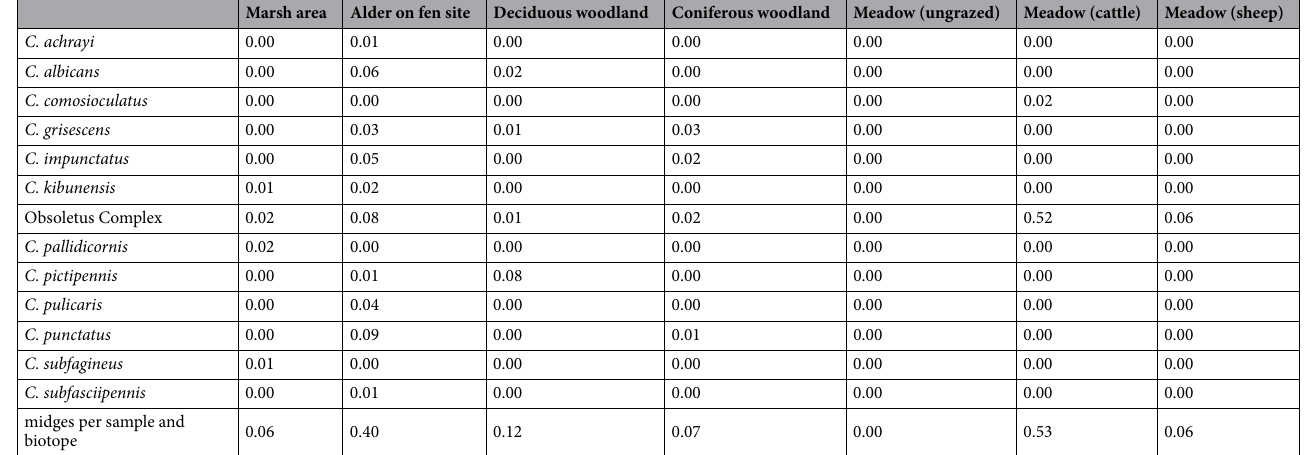
Table 4. Number of collected culicoid species per biotope and